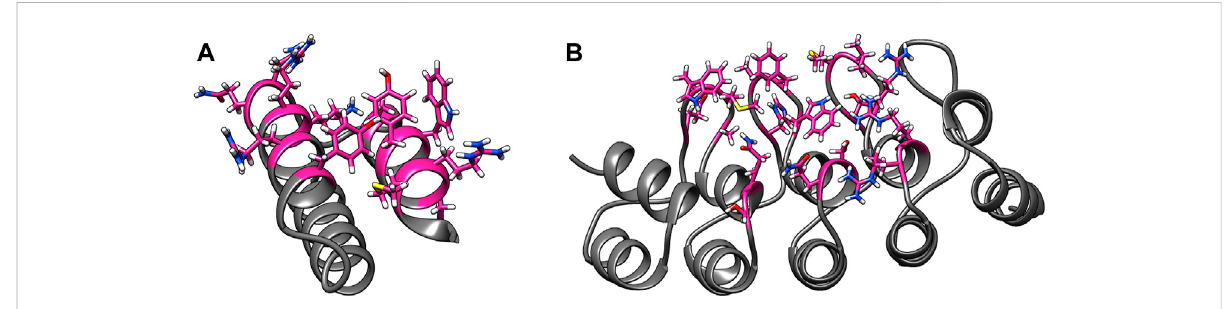
FIGURE 1 Examples ofalternative bindingscaffolds.Depictedare (A) Af fi body (PDB:3MZW)and (B) DARPin(PDB: 6FPA)structures.Theirvariable residues that mutate to bind target proteins are colored in